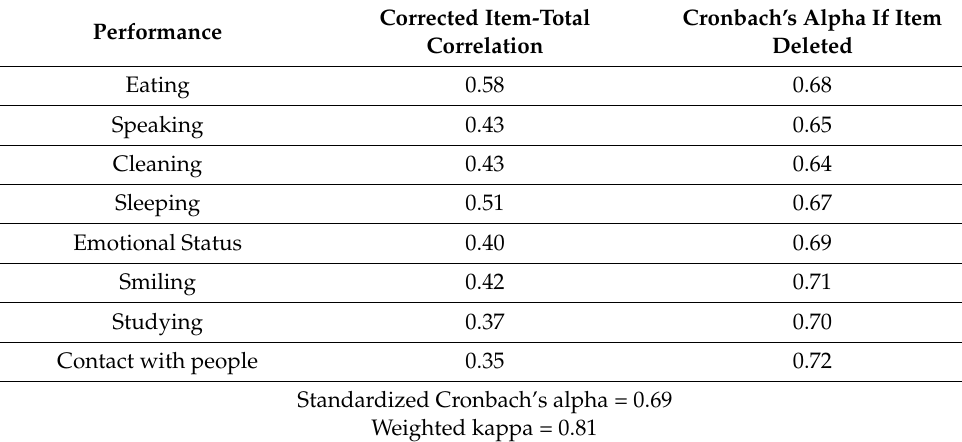
Table 2. Cronbach’s alpha, item-total correlation and alpha with deleted